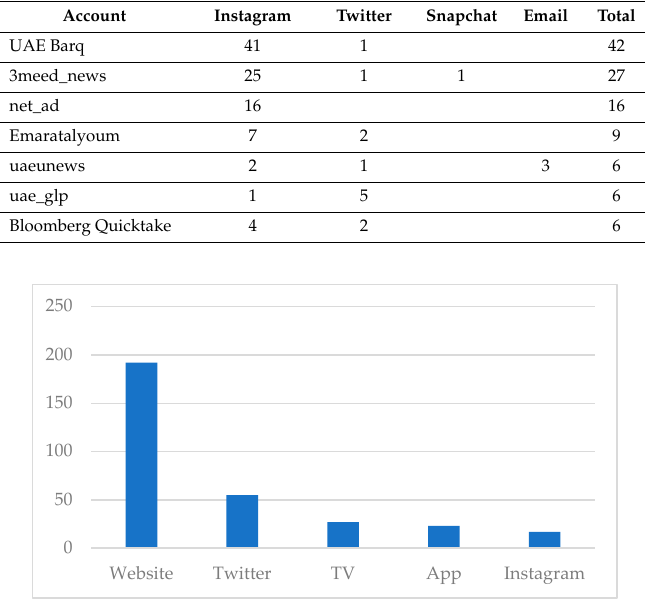
Figure 2. Top five platforms used to access all media.